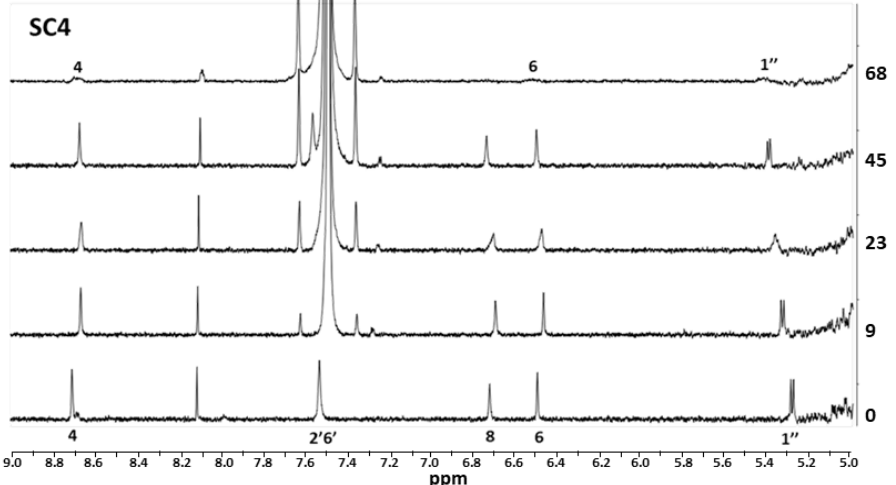
Figure 5. 1 H NMR spectra variations of Oenin (2.2 × 10 −4 M) solution upon titration with increasing concentrations of the host: 0, 9, 23, 45, and 68 equivalents of SC4. concentrations of the host: 0, 9, 23, 45, and 68 equivalents of